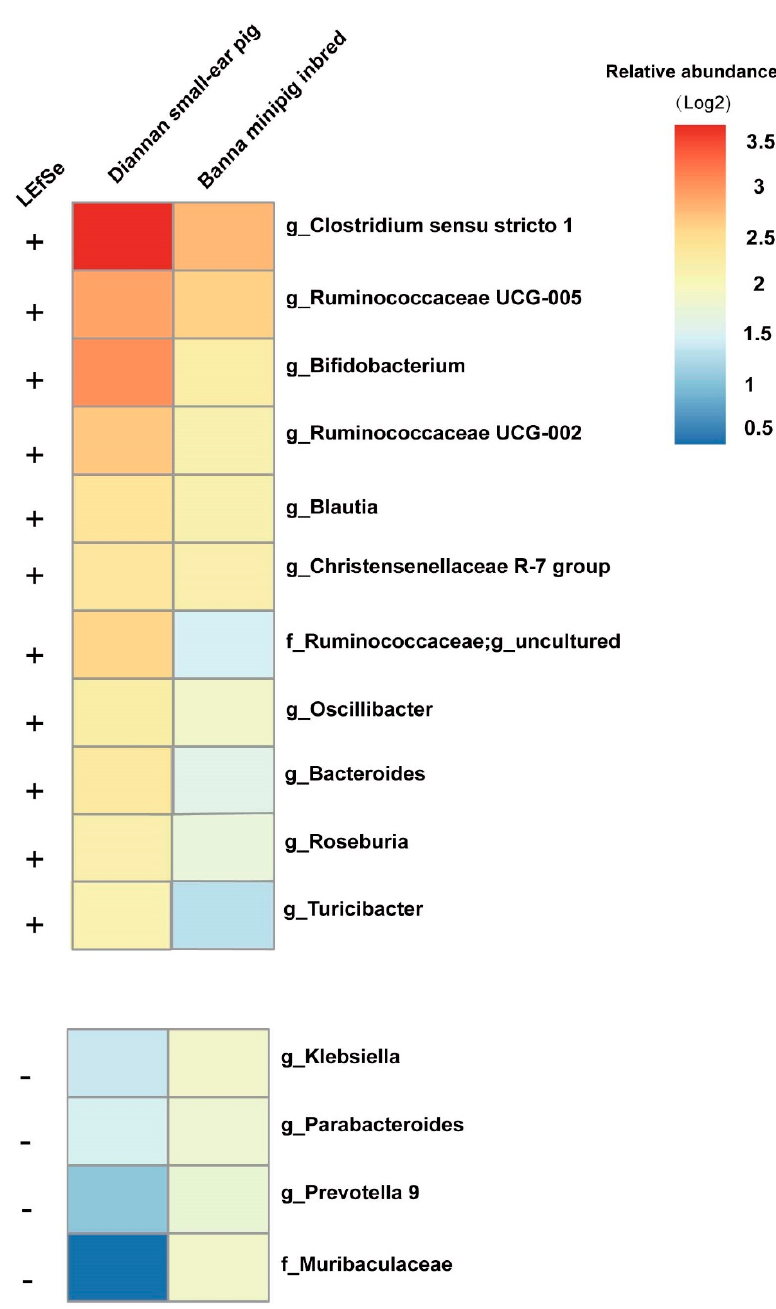
UniFrac. ANOSIM, p < 0.01, Red squares and green circles respectively represented Diannan small-ear pig and Banna minipig inbred bacterial communities. Figure 3I, J shows the between-group and within- group distance based on Jaccard ( I ) and Bray–Curtis ( J ). DD: Distance within group of Diannan small- ear pig, BB: Distance within group of Banna minipig inbred, BD: The distance between the Diannan